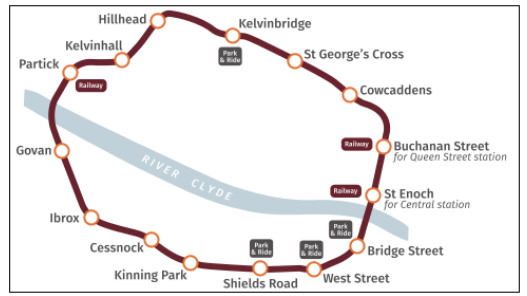
Figure 8. Glasgow orbital metro system